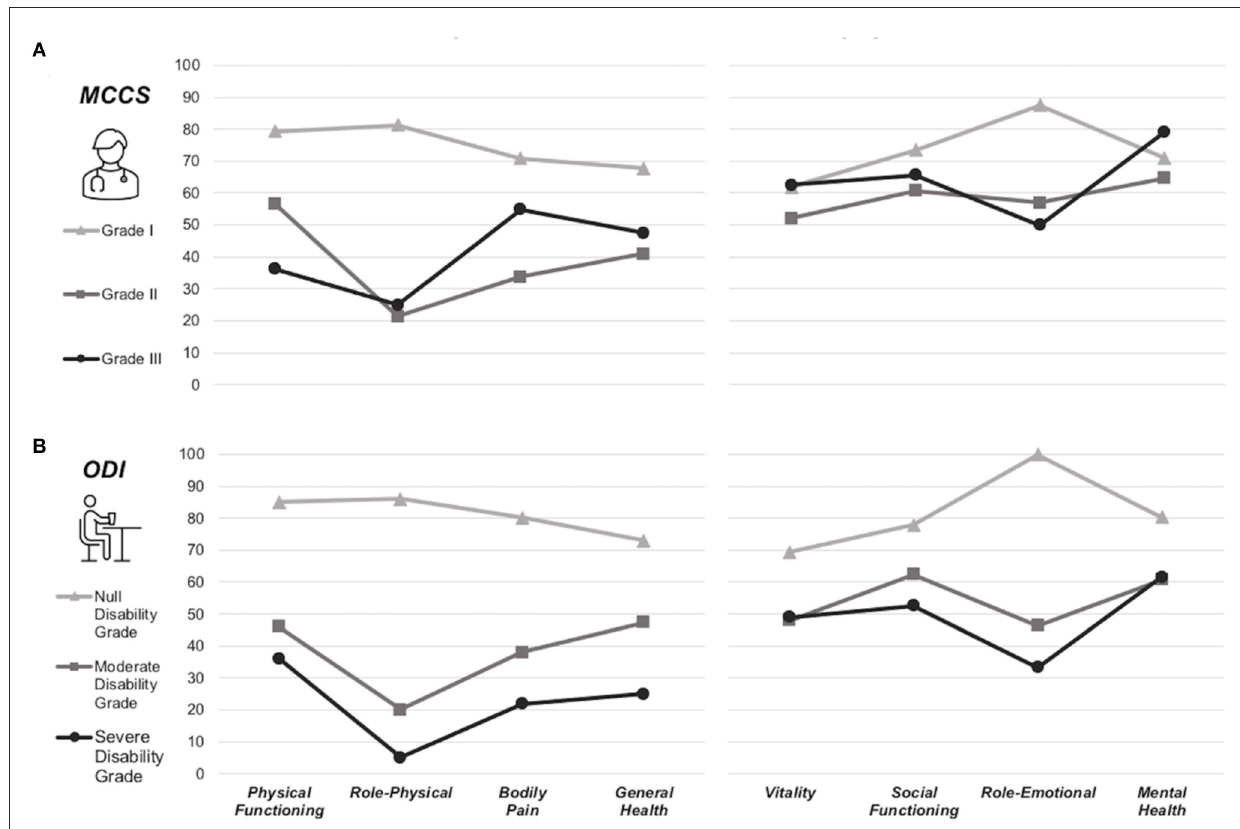
FIGURE2 Interaction between SF-36 subscales and the neurological or perceived disability grade. ANOVAs conducted on the SF-36 subscales with (A) the degree of clinical disability (MMCS) measured at the chronic stage and (B) the perceived disability (ODI) measured at follow-up, as between-subject factors. Different grades of postoperative neurological evaluation reflect differences in the patients’ self-perception of health 15 years after the